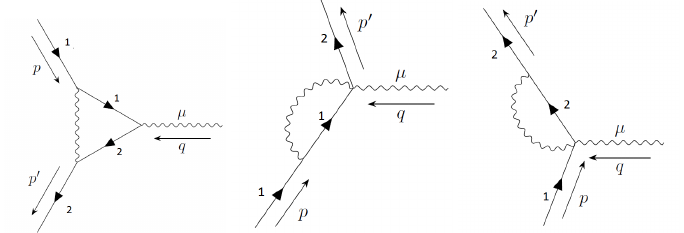
Figure 4. One loop contribution to the three-point proper